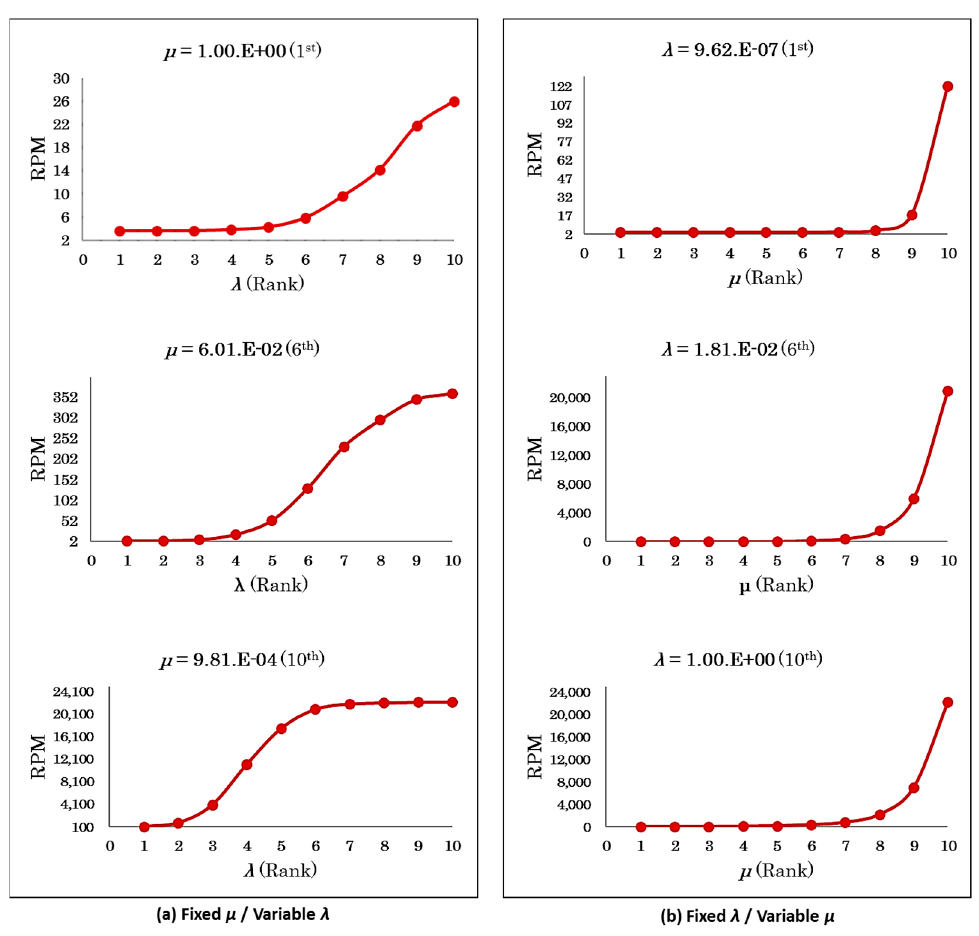
Figure A1. Risk-prioritization metric ( RPM ) graph with respect to the failure occurrence rate 𝜆 and failure-cause detection rate 𝜇 ( 𝑐 = 1 , 𝜀 = 0.0181 , 𝛼 = 200 , 𝛽 = 1000 , and 𝜃 = 1200 ). ( a ) RPM as a function of 𝜆 draws S-curve, and ( b ) RPM of 𝜇 increases rapidly more than exponential. Thus, the RPM is more sensitive to 𝜇 than 𝜆 . Table A1. Risk-prioritization metric ( RPM ) table with respect to the failure occurrence rate 𝜆 and failure-cause detection rate 𝜇 ( 𝑐 = 1 , 𝜀 = 0.0181 , 𝛼 = 200 , 𝛽 = 1000 , and 𝜃 = 1200 ) 𝝁 𝝀